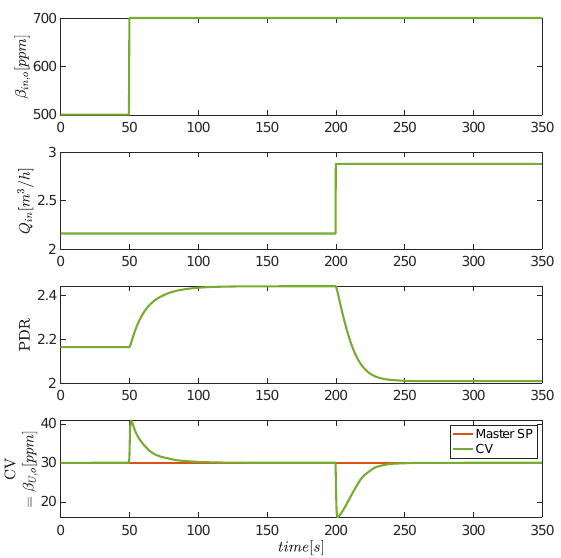
Figure 9: Simulation result showing the cascade con- trol scheme. Here the inlet oil concentra- tion is changed at 50 s and the inflow rate is changed at 200